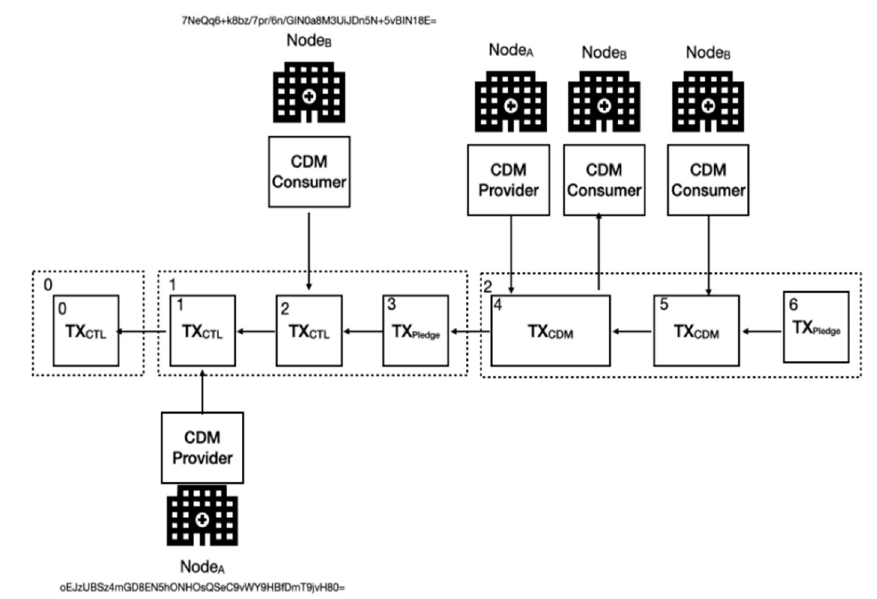
Figure 10. The block consists of a set of transactions in SC-Blockchain.